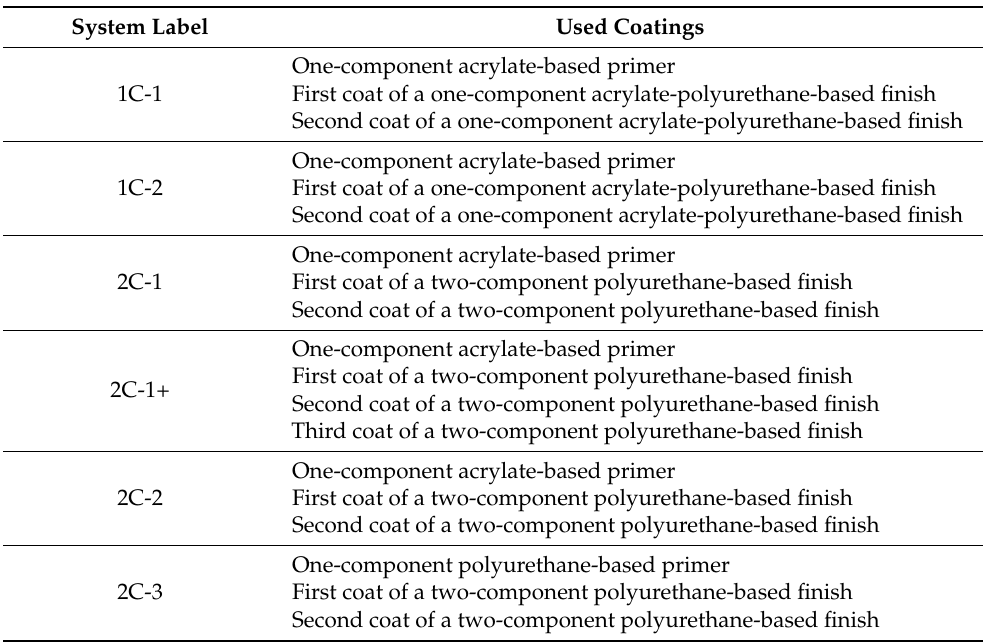
Table 1. Structure of the used waterborne coating systems. System